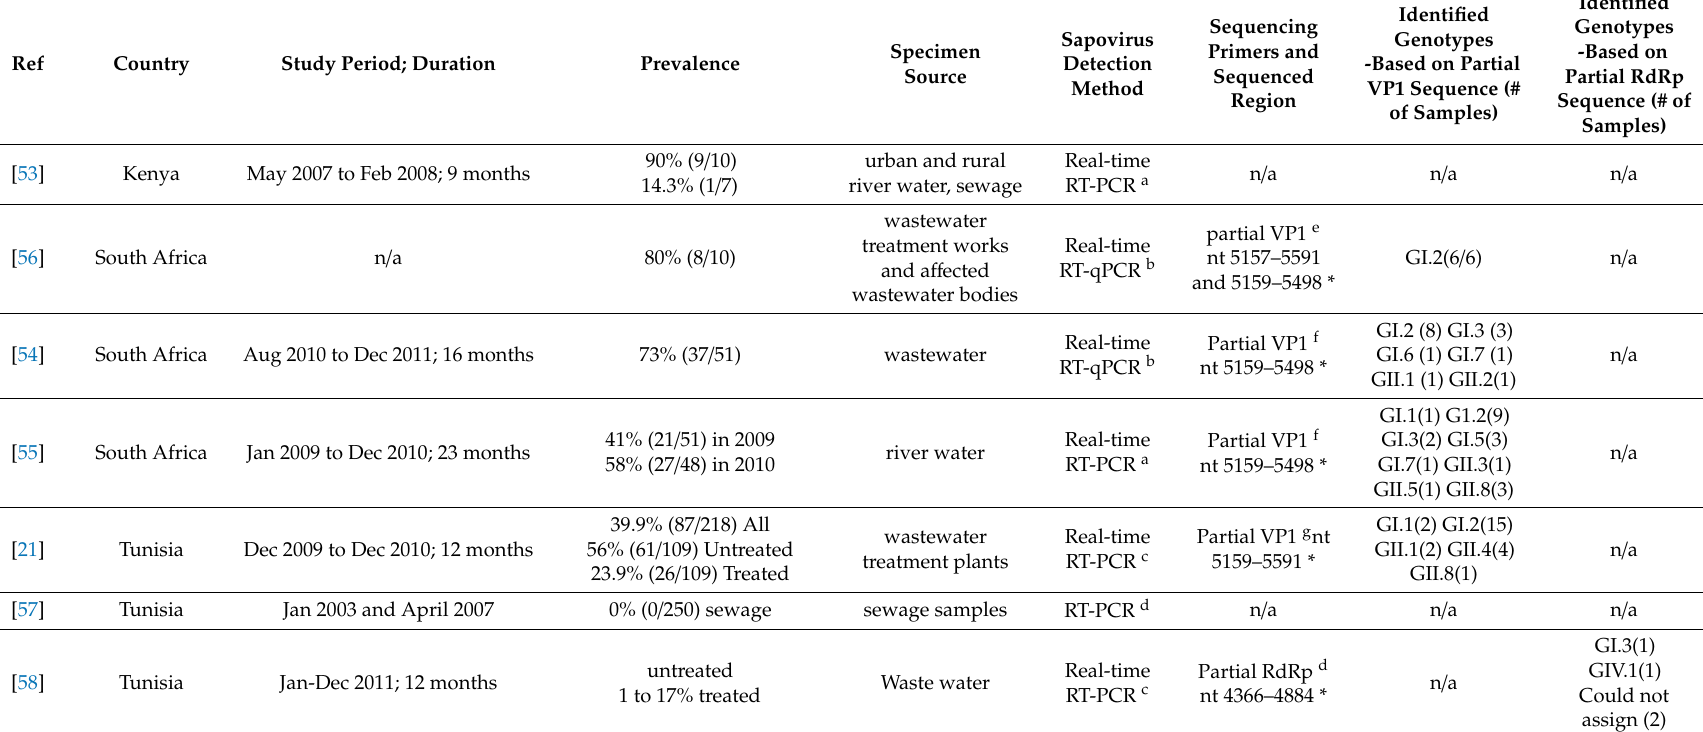
Table 3. Summary of reported studies of environmental sapovirus in